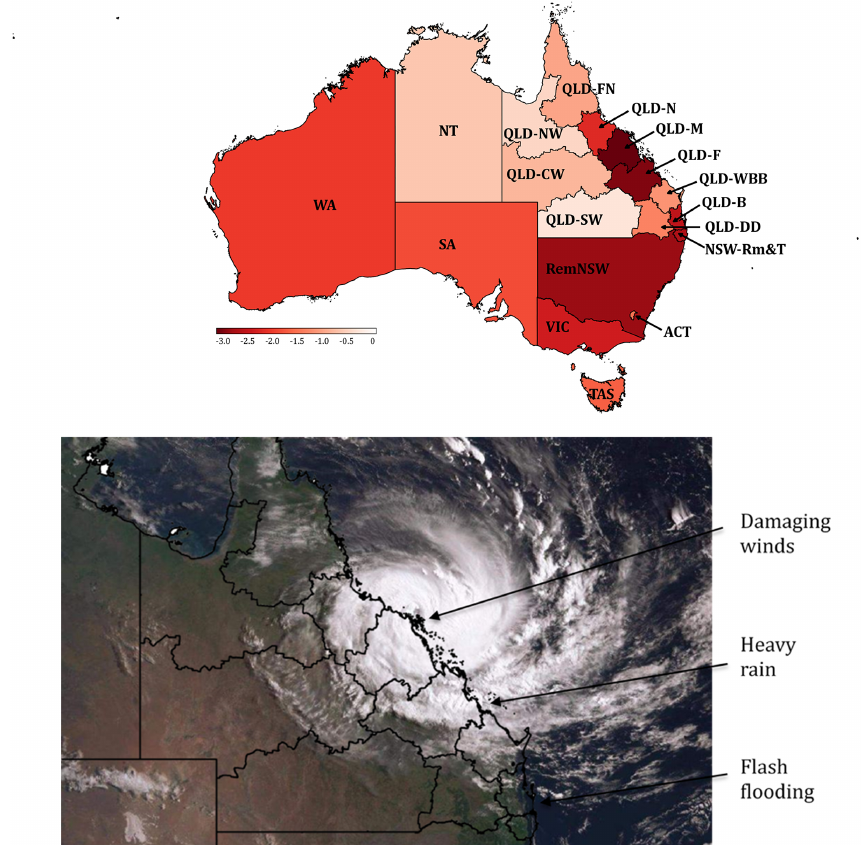
Figure 1. Geographical distribution of value-added loss caused by Tropical Cyclone Debbie. Value-added (VA) loss is expressed as (cid:49) VA = q VA ( I − A ) − 1 (cid:49) y . A comparison of our results (top, − log 10 ( (cid:49) VA), with (cid:49) VA in AUDm) with a satellite image of the cyclone (ABC, 2017) (bottom) shows losses in northern Queensland regions as a direct consequence of the destructive winds and losses in southern Queensland and northern NSW as a result of heavy rain and floods occurring in the cyclone’s wake. Region acronyms: RemNSW is the rest of New South Wales (NSW), NSW-Rm & T is NSW Richmond & Tweed, VIC is Victoria, QLD-B is Queensland (QLD) – Brisbane, QLD-WBB is Wide Bay Burnett, QLD-DD is Darling Downs, QL-SW is South West, QLD-F is Fitzroy, QLD-CW is Central West, QLD- M Mackay, QLD-N is North, QLD-FN is Far North, QLD-NW is North West, SA is South Australia, WA is Western Australia, TAS is Tasmania, ACT is Australian Capital Territory, NT is Northern Territory. Note that the Brisbane region in this study covers and area similar to an area generally referred to as “South-east